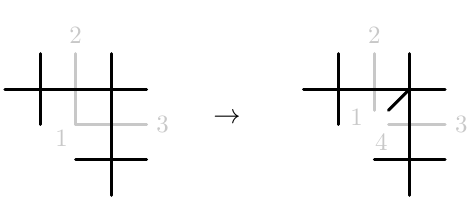
Figure 4 . On the left hand side we have an example of a massive tree-level fishnet diagram with multiple propagators adjacent to the same external region 1 (or the dual diagram with multiple propagators connected to the same external region momentum). At tree level and one loop such diagrams are annihilated by the level-one symmetry with extra-dimensional contribution b J A + b J A At higher loops we introduce a point-splitting in region momentum space alias an additional leg in momentum space (right hand side), such that the diagram is annihilated by the generators b J A without extra